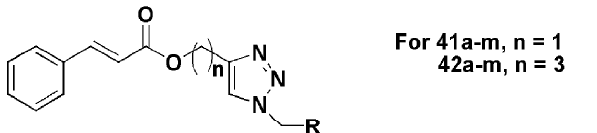
Figure 10. Chemical structures of compounds 41a–m and 42a–m [38].